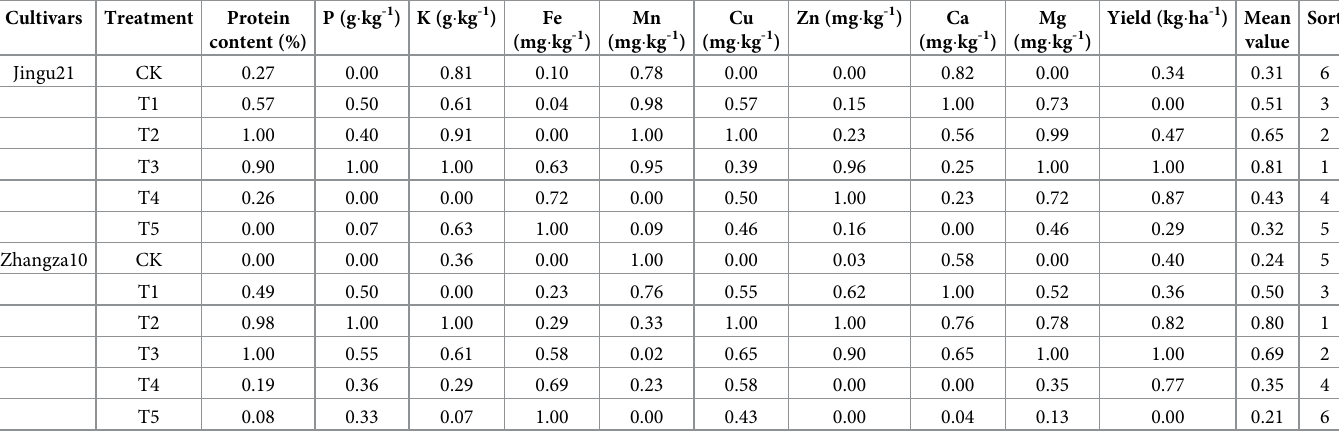
Table 3. Membership function value of humic acid action on foxtail millet and comprehensive evaluation. Cultivars Treatment